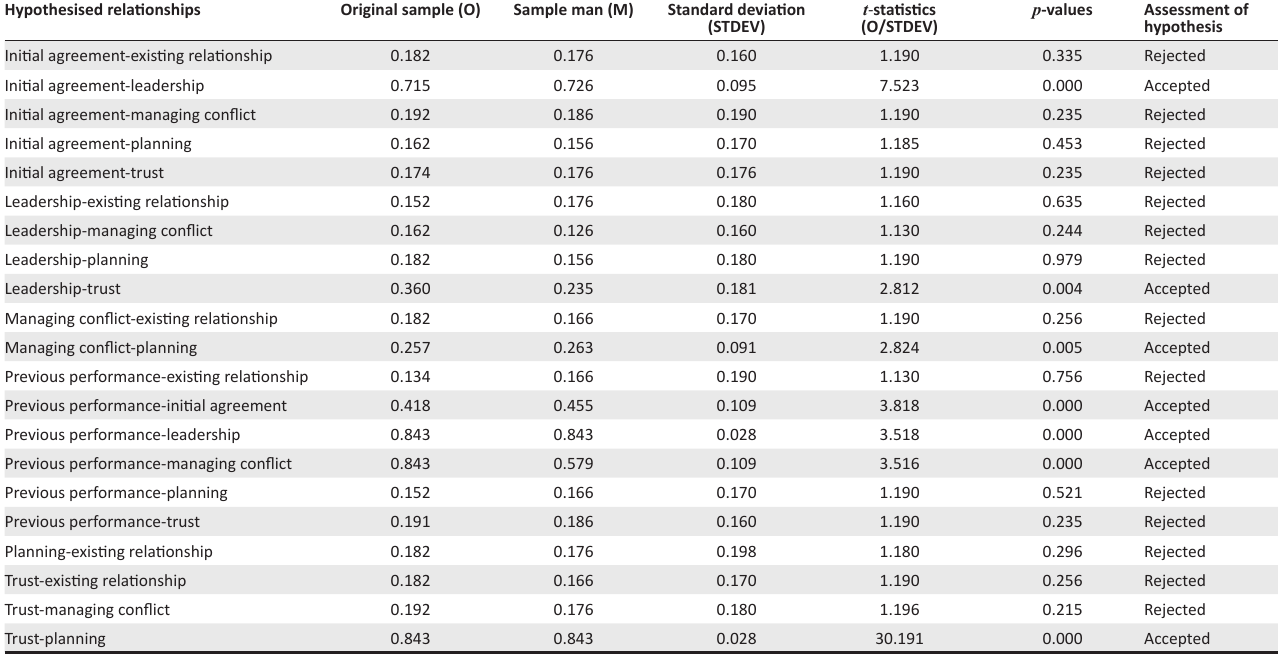
TABLE 2: Hypotheses testing: Summary of the path analysis evaluation. Hypothesised